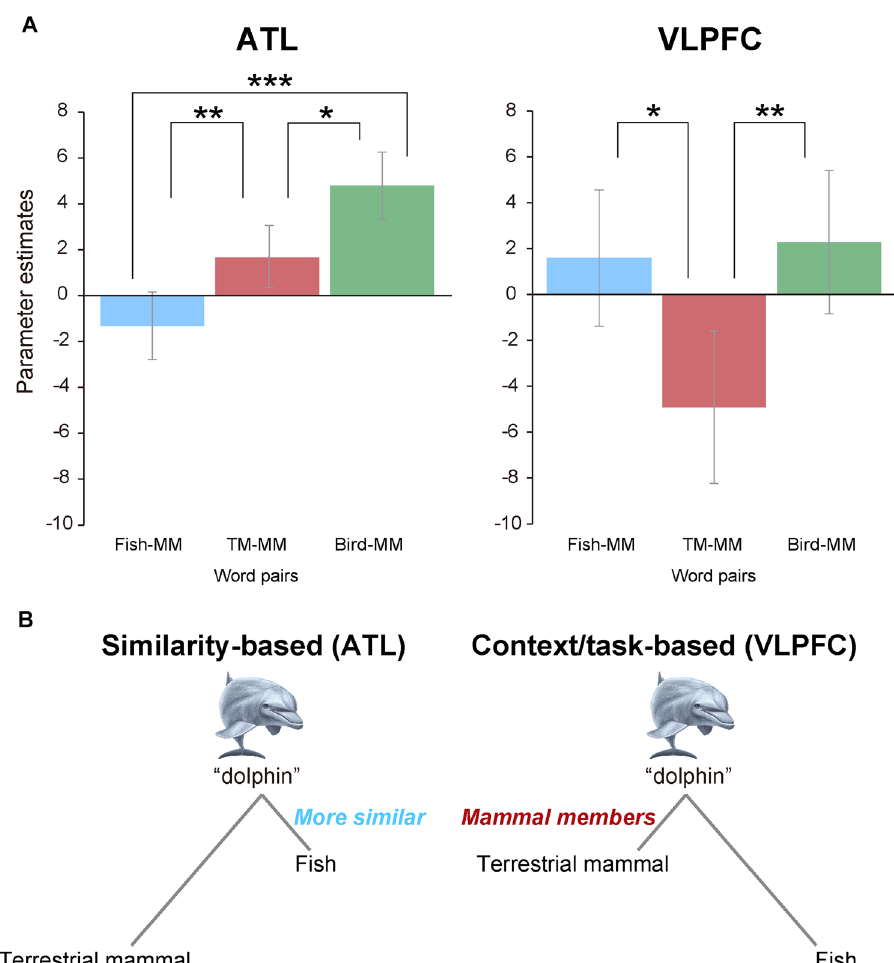
Figure 4. Activations of three MM target conditions in the left ATL and left VLPFC (spherical ROIs centered at the peak voxels of each cluster). ( A ) In the left ATL, the priming effect (i.e., reduction of activation) is observed both in TM-MM and Fish-MM conditions. The priming effect for Fish-MM is larger than that for TM-MM (i.e. priming effects are proportional to semantic distance from MM). In the left VLPFC, the priming effect is shown in the TM-MM condition. ( B ) Conceptual figures represent differential roles between the left ATL and left VLPFC during semantic processing. Dolphins are represented close to fish in the left ATL, whereas they are categorized as mammal in the left VLPFC in this context. Error bars show standard error. * p < .05, ** p < .01, *** p < .001. The illustrations of dolphin are copyrighted by M/Y/D/S (Yokohama,